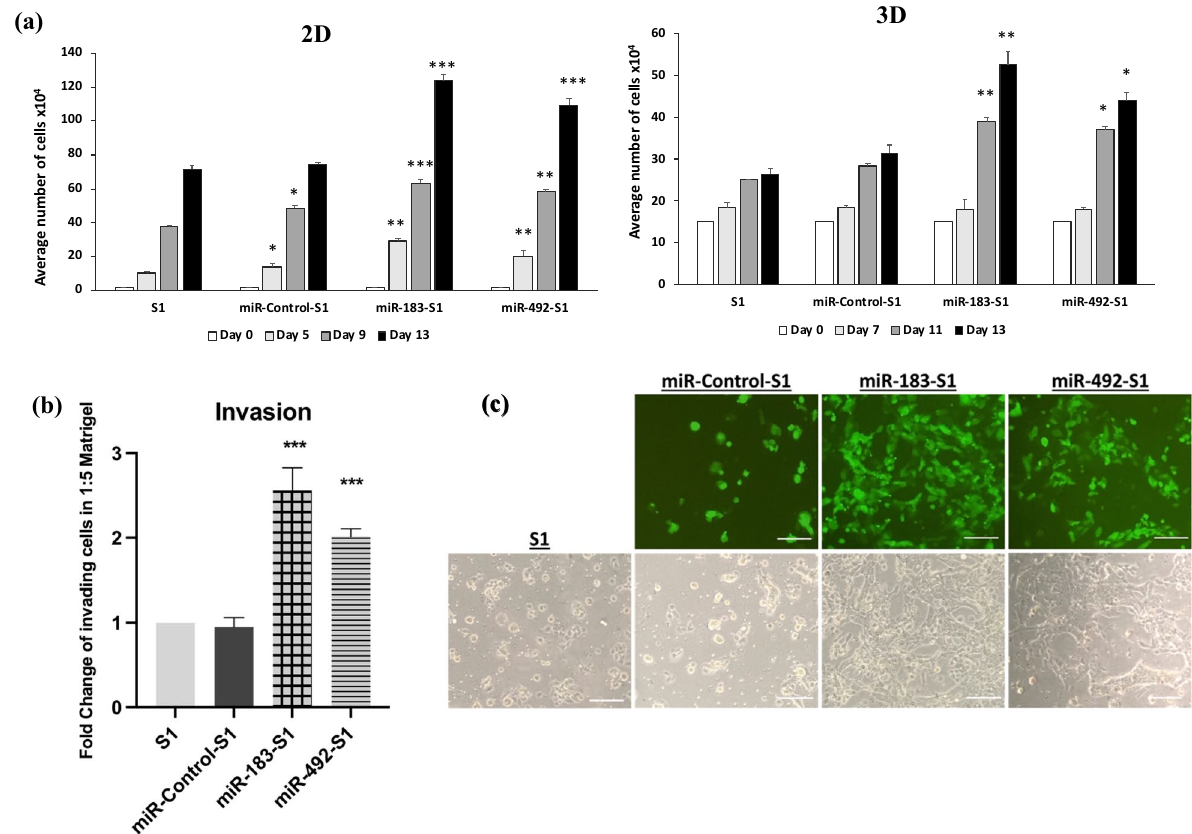
Figure 4. Assessment of proliferation and invasion upon over-expressing miR-183 and miR-492 in non- neoplastic S1 cells. ( a ) S1, miR-Control-S1, miR-492-S1 and miR-183-S1 cells were cultured in 2D or 3D conditions. Proliferation rate was assessed by cell counting on days 5, 9 and 13 in 2D cultures and on days 7, 11 and 13 in 3D cultures. Experiments were repeated at least three times. The values depicted in the histograms are the means (± standard error of the mean, SEM) of cell counts. ( b , c ) Invasion of S1, miR-Control-S1, miR-492-S1 and miR-183-S1 cells cultured in diluted Matrigel (1:5) for 72 h. Invasion was assessed by trans-well cell invasion assay. The values depicted in the histogram ( b ) denote the fold change of the number of invading cells (± SEM) from three separate experiments. ( c ) Representative images of the invading cells after 72 h of being cultured in diluted Matrigel (1:5). Scale bar represents 80 pixels at 10X magnification. *** denotes a p-value < 0.001, ** denotes a p-value < 0.01 and * denotes a p-value < 0.05 by unpaired t